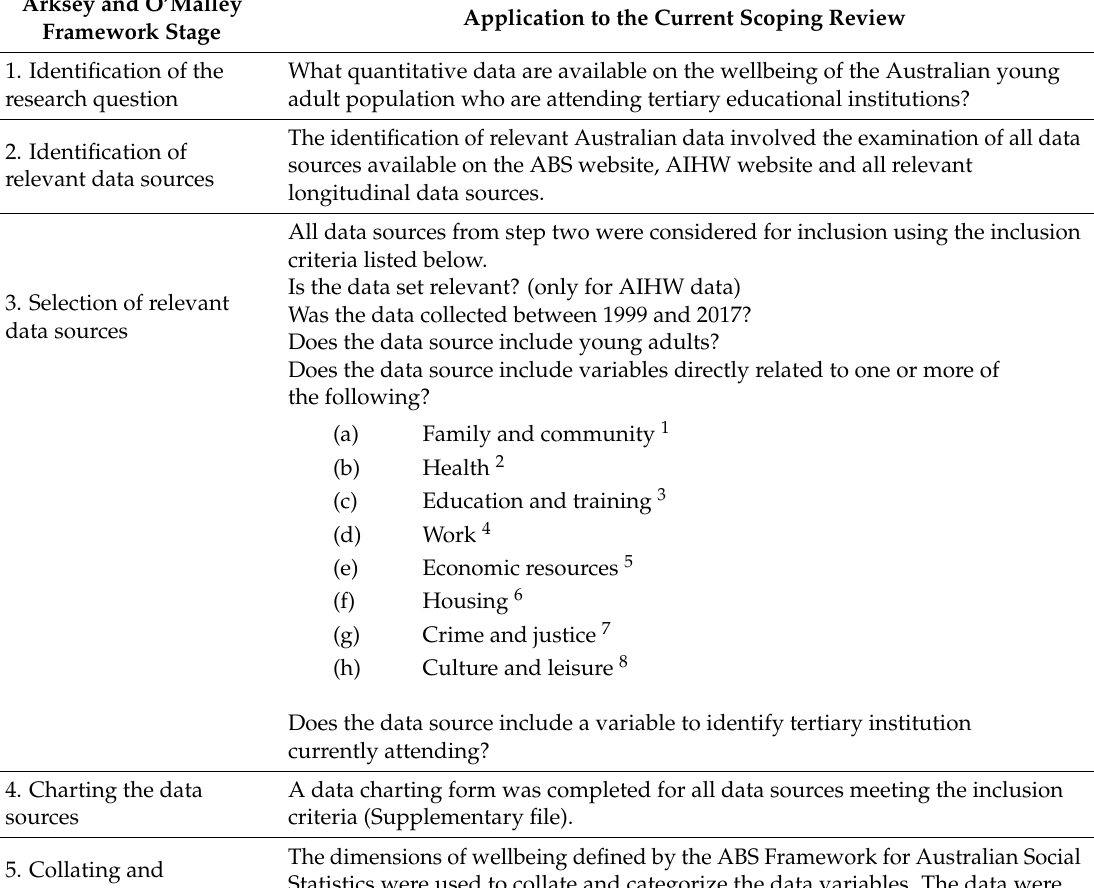
Table 1. Overview of the Arksey and O’Malley methodological framework and application to the scoping